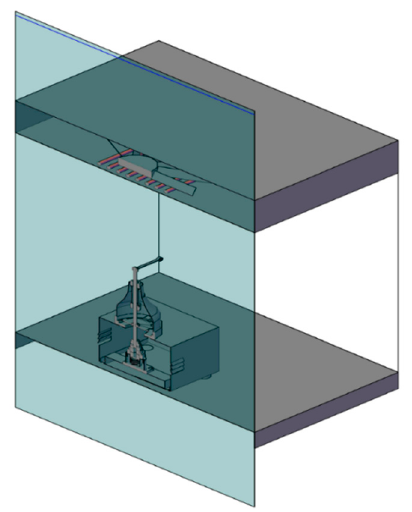
Figure 7. Cross-section of the testing chamber of the computerized flight mill.